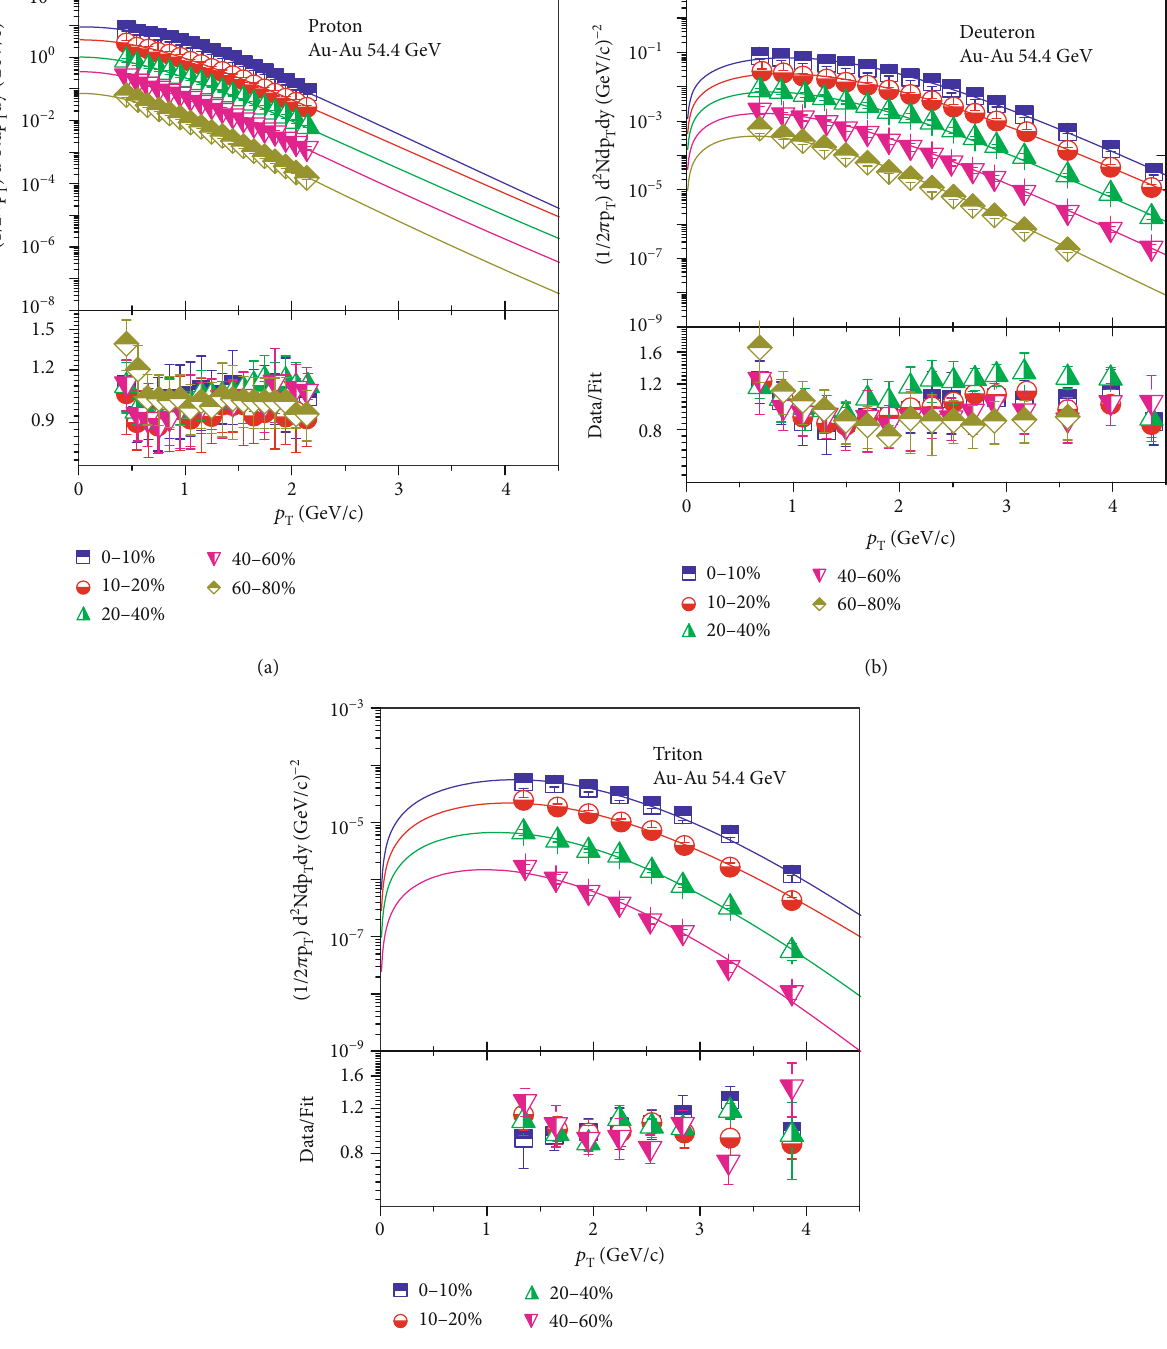
Figure 1: Transverse mass spectra of (a – c) p , d , and t produced in di ff erent centrality bins in Au-Au collisions at symbols represent the experimental data measured by the STAR Collaboration at ∣ y ∣ <0 : 5 [40]. The curves are our fi tted results by Equation (1). Each panel is followed by its corresponding ratios of data/ fi